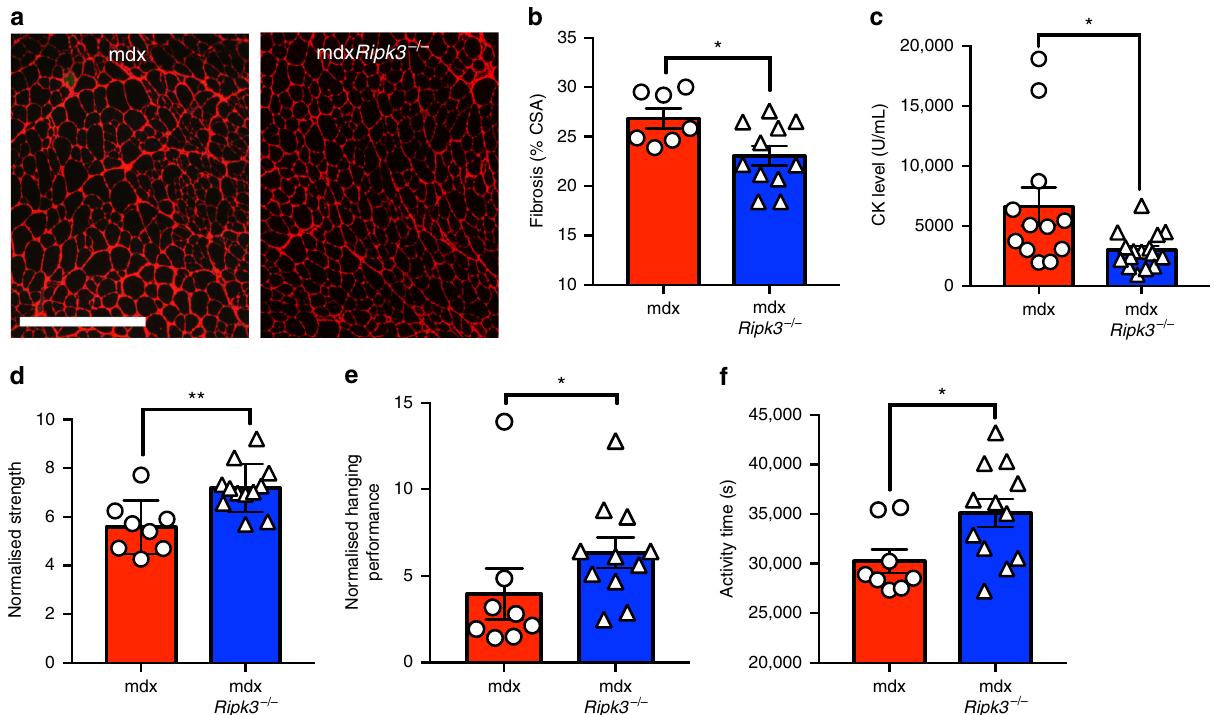
Fig. 4 RIPK3 de fi ciency ameliorates muscle phenotype in adult mice. a Representative image of extracellular matrix deposition in TA muscles of 9-week-old mice. Extracellular matrix was stained with antibodies to laminin and collagen VI together (red). Scale bar, 500 µ m. b Quanti fi cation of extracellular matrix deposition ( fi brosis) in TA of 9-week-old mice. Total extracellular matrix area was expressed as percentage of cross-sectional area ( n = 7 mdx, n = 11 d Quanti fi cation of grip strength and e hanging performance (expressed as the ratio: maximum hanging time (in s)/body weight; n = 8 mdx, n =